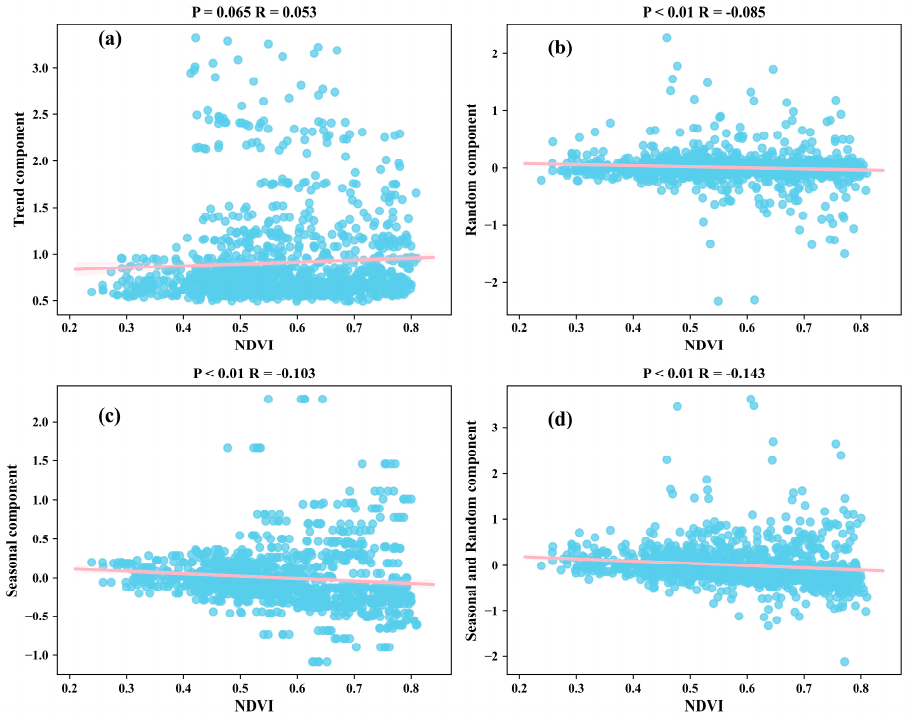
Figure 12. The correction between mean NDVI (Normalized Di ff erence Vegetation Index) values and ( a ) trend component, ( b ) random component, ( c ) seasonal component, and ( d ) sum of seasonal and random